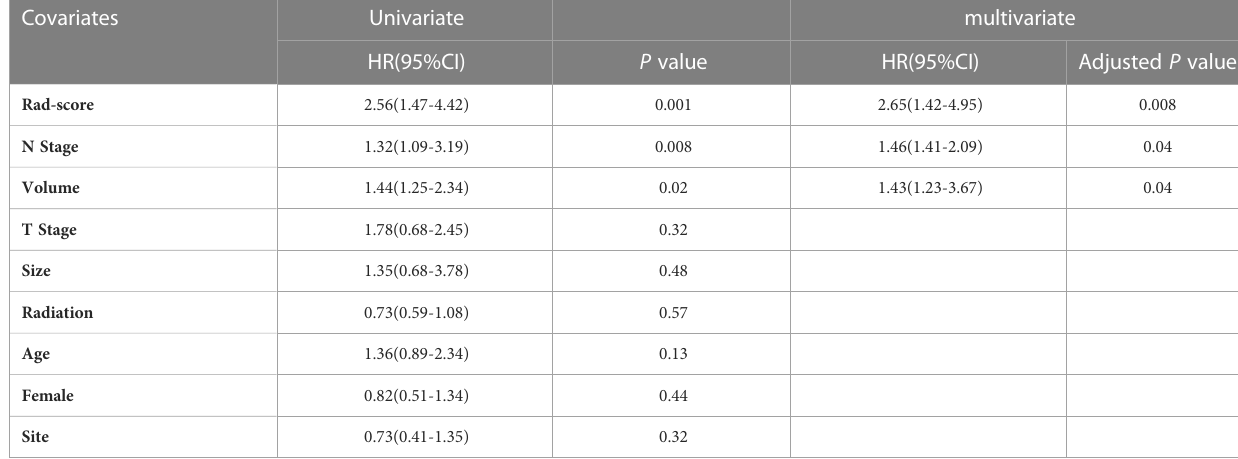
TABLE 3 Univariate and multivariate analysis with Cox proportional hazard model in Training cohort.